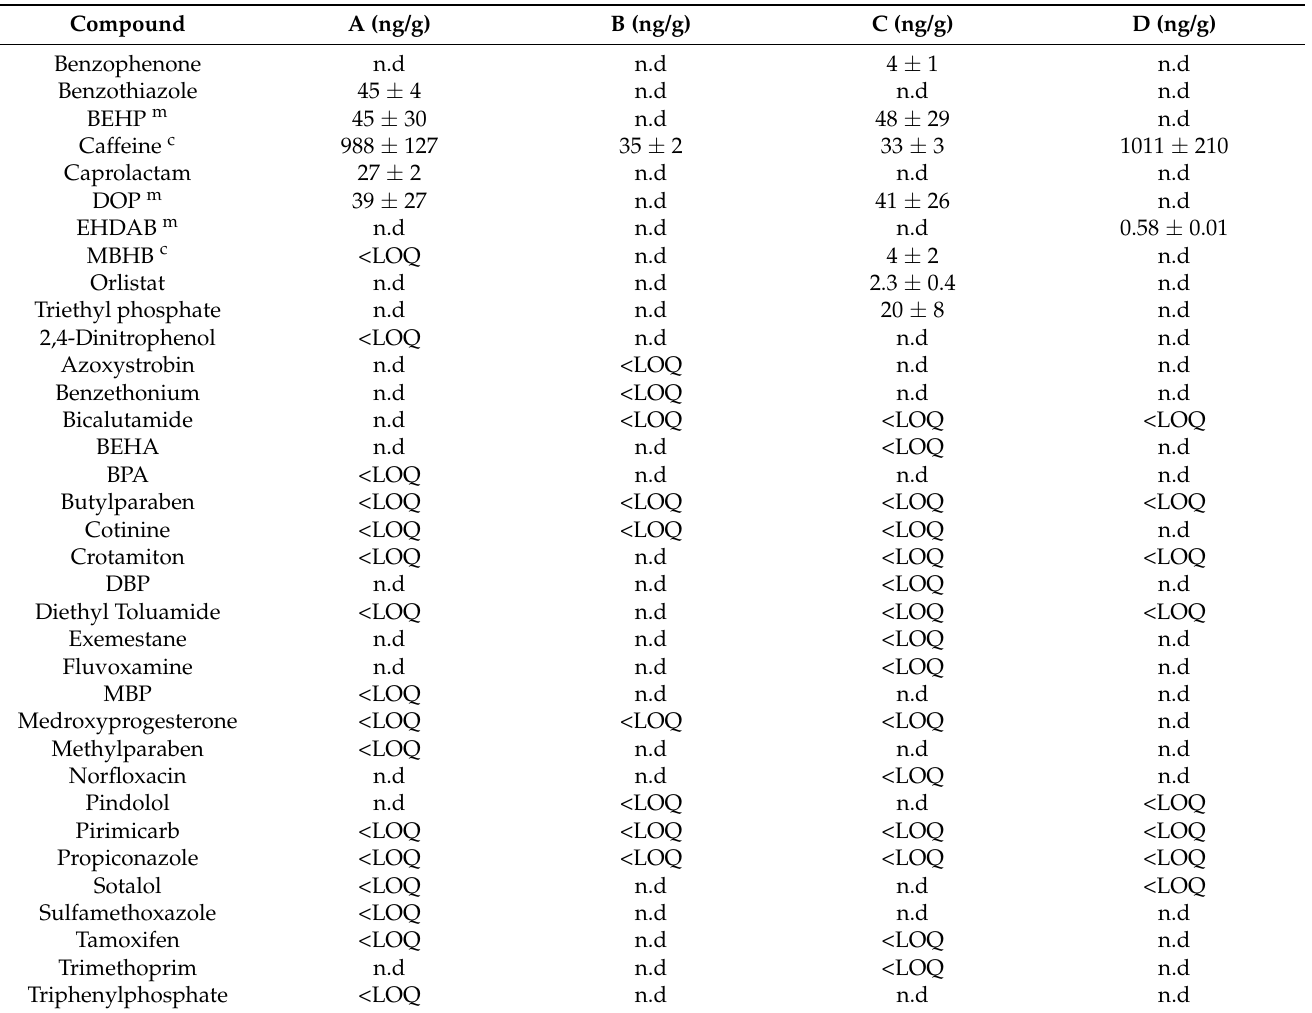
Table 5. Target analysis results: average concentration of xenobiotics (95%, 2 s) in breast milk samples. Compound A (ng/g) B (ng/g)